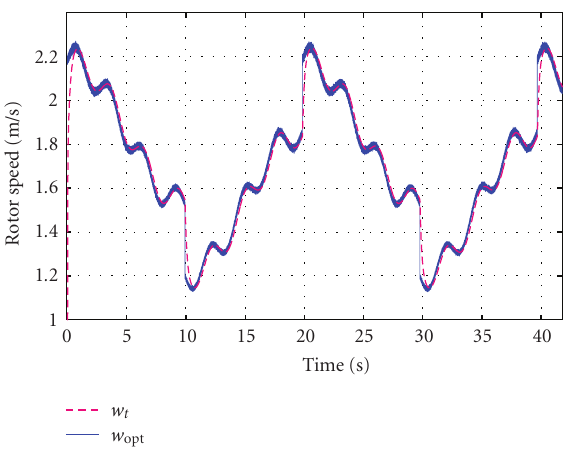
Figure 4: Structural diagram of hybrid wind-diesel-storage system.